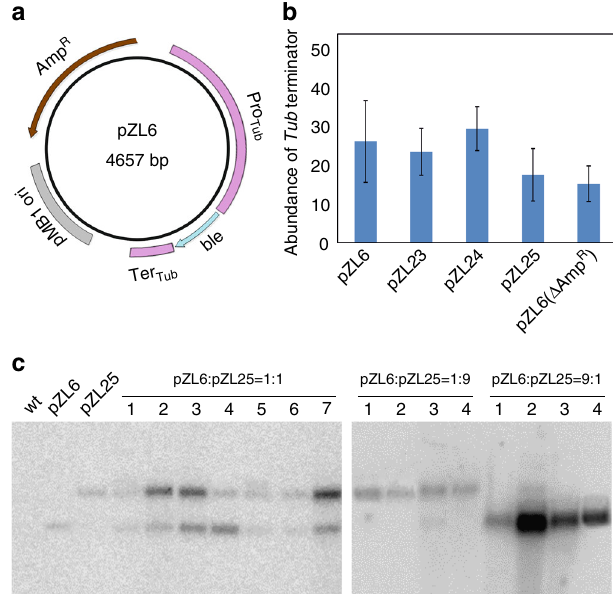
Fig. 3 Bacterial replication origins confer episomal replication in P. purpureum . a Map of plasmid pZL6 with the main functional elements indicated. Amp R : ampicillin resistance gene bla ; Pro Tub : tubulin gene promoter driving the selectable marker gene ble for algal transformation; ble : bleomycin (zeocin) resistance gene; Ter Tub : terminator derived from the tubulin gene of P. purpureum ; pMB1 ori: origin of replication of the plasmid in E. coli . b Measurement of episome copy numbers for the different constructs listed in Table 1. Copy numbers were determined by